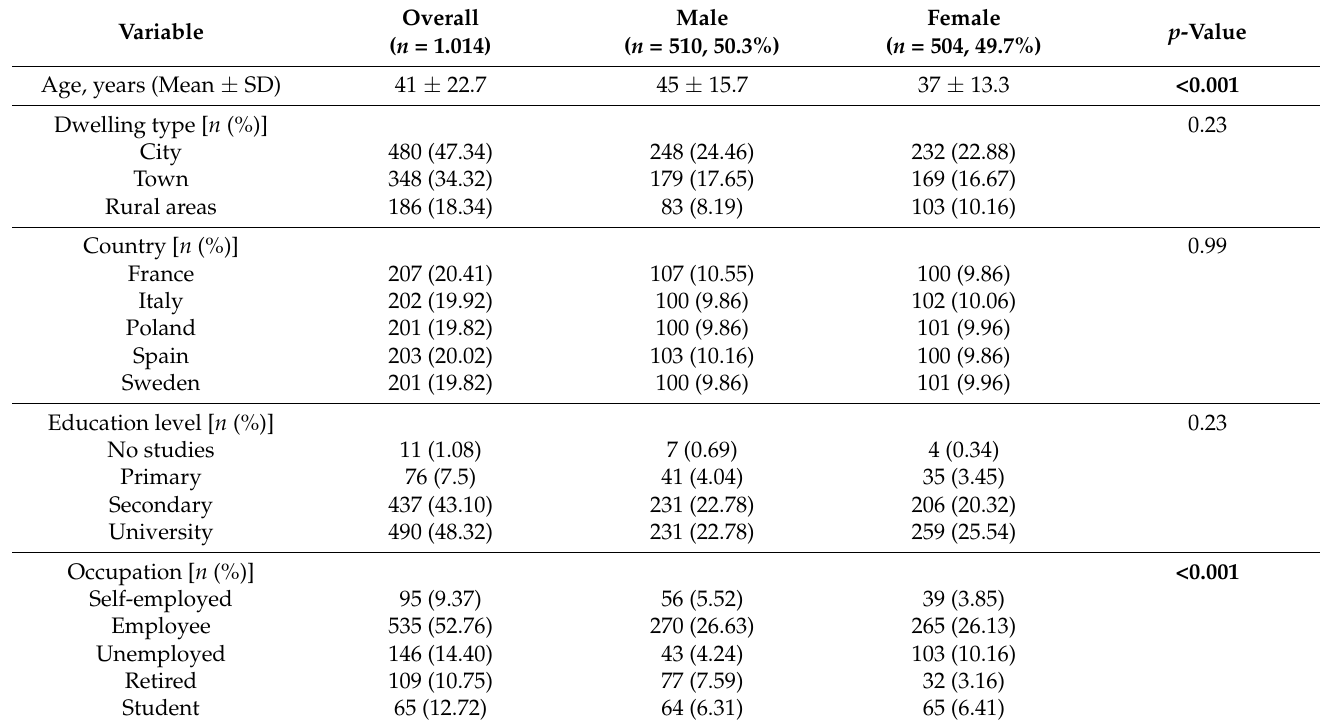
Table 3. Baseline characteristics of study participants. Significant p -values in